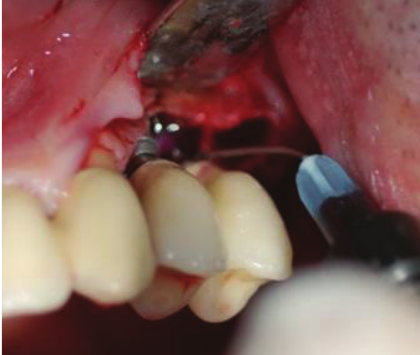
Figure 5: HYBENX was administered on the implant surface for 60 seconds and then thoroughly rinsed away with saline.